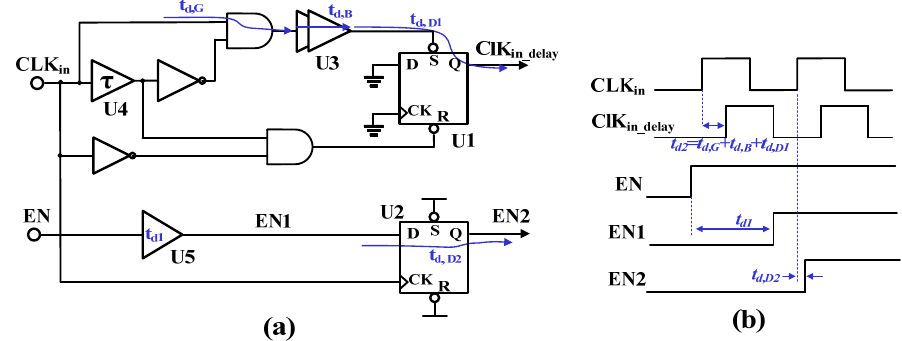
Figure 8. The initial phase error reduction principle: ( a ) the schematic and ( b ) its signal propagation delay.